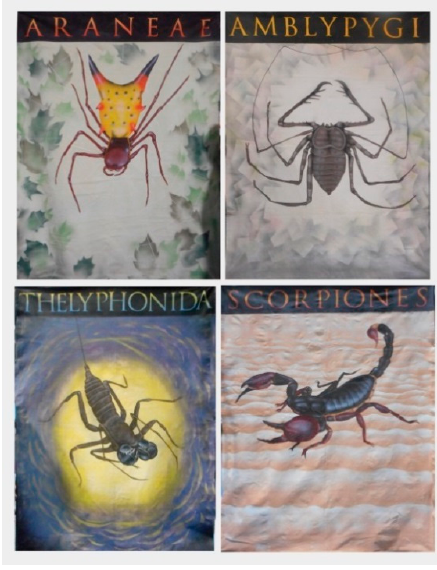
Figure 2. Six-by-eight foot original canvases were used to draw in attendees at the Toledo Zoo’s Path of Predators event.